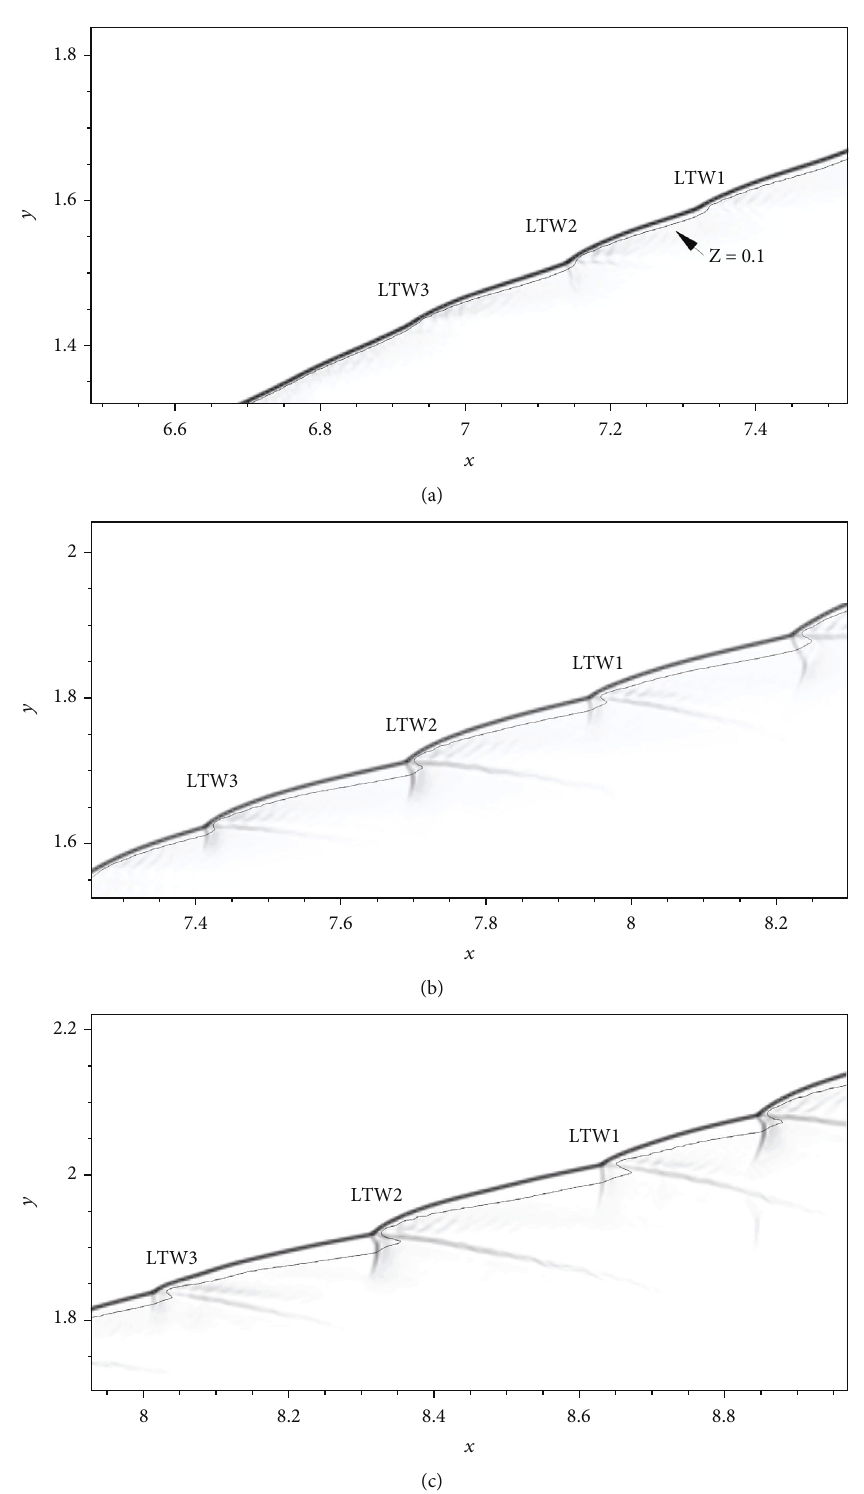
Figure 9: Temporal evolution of the density gradient contour and the LRTWs at di ff erent times. (a) t = 15 : 2 . (b) t = 15 : 4 . (c) t = 15 : 6